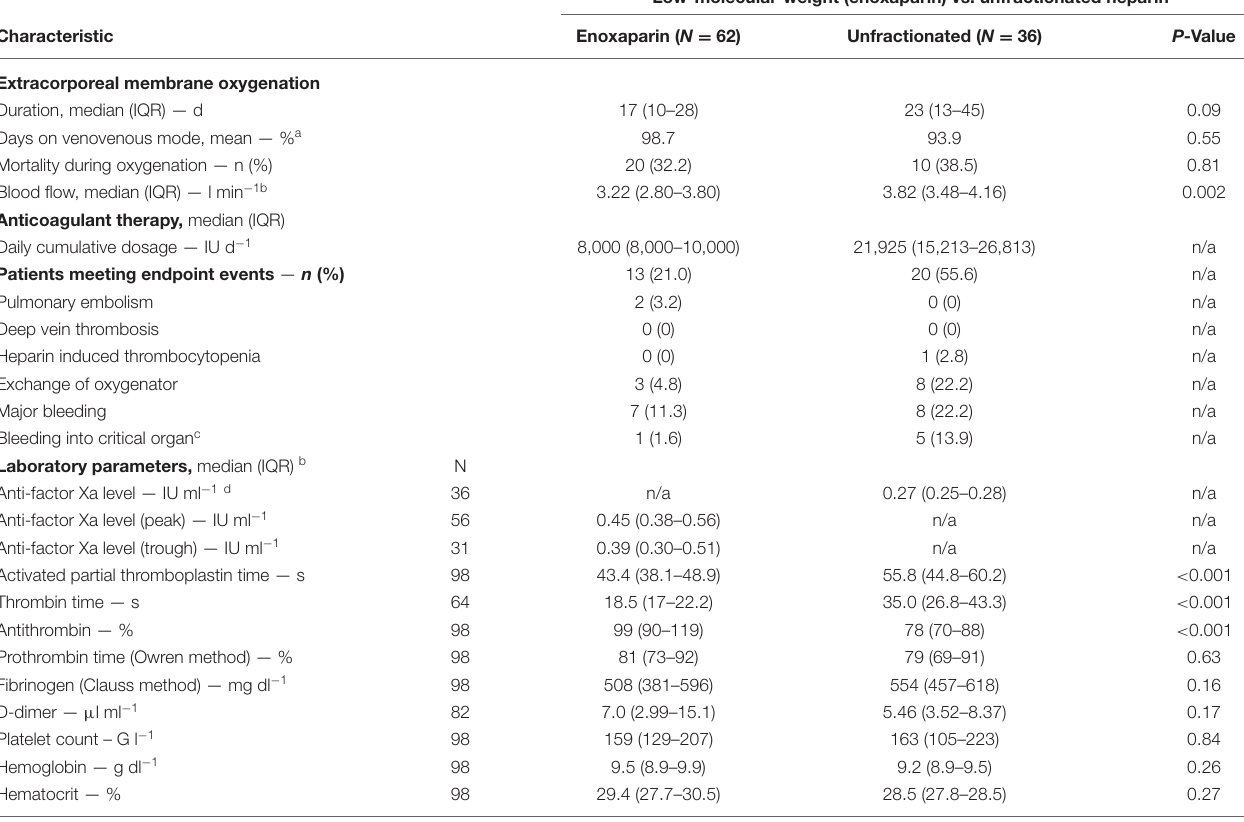
Low-molecular-weight (enoxaparin) vs. unfractionated